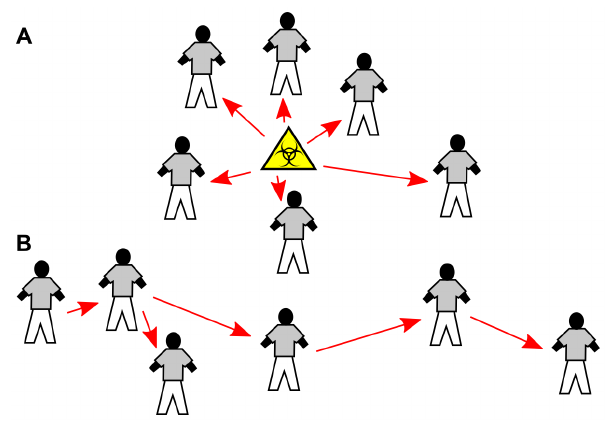
Figure 1. Different patterns of disease clusters. Clusters of disease cases caused by a point source (A) show a different pattern than clusters caused by human-to-human transmission of a contagious disease (B). (A) When there is a point source cases tend to be found in the region around it. Modern scan statistics exploiting this pattern have been developed to find evidence of point sources causing disease. (B) When contagious diseases are spread by human-to-human transmis- sion, clusters tend to be more chain-like; the relevant distances are those between pairs of cases rather than between case and point source. Although it is still possible to find clusters in situation (B) with algorithms developed for (A), the problem can be handled more naturally by taking into account the different cluster